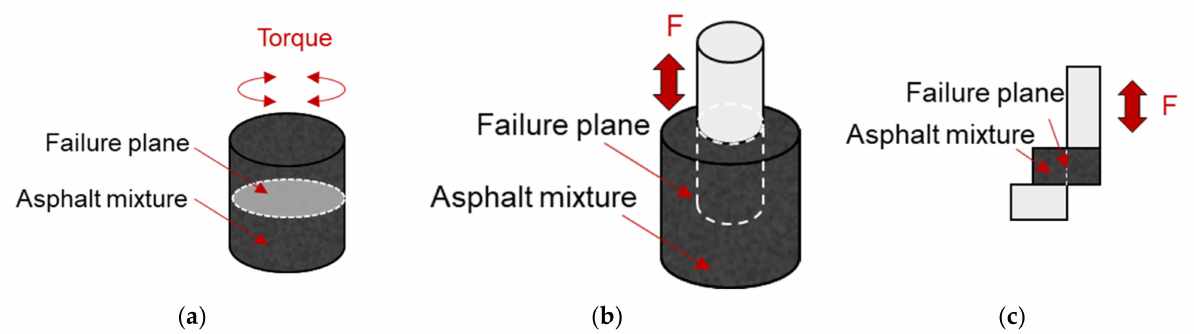
Figure 11. Schematic of shear fatigue test configurations. ( a ) Torsional shear. ( b ) Penetration shear. ( c ) Direct